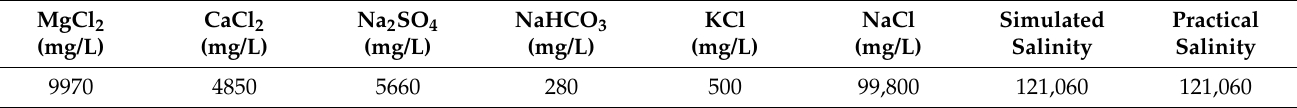
Table 1. Practical salinity and simulated reservoir liquid.